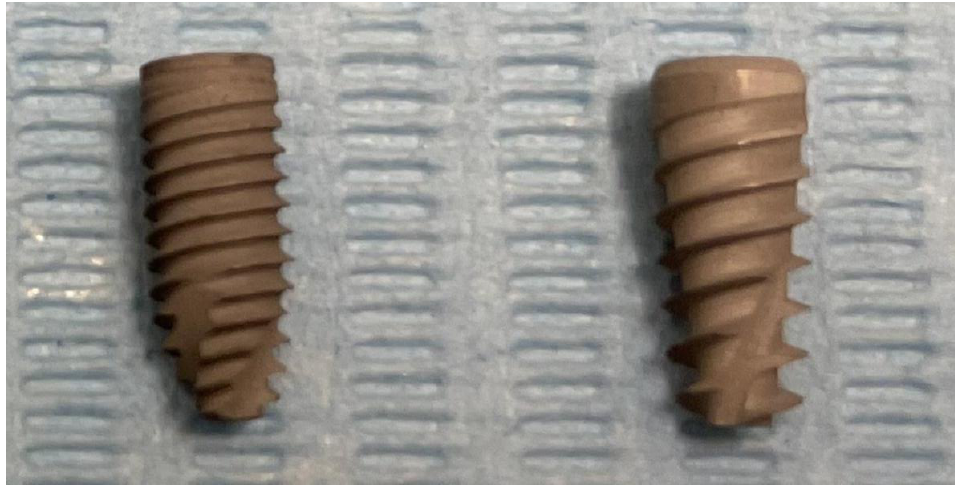
Figure 1. Details of the cylindrical and tapered implants tested in the present investigation.